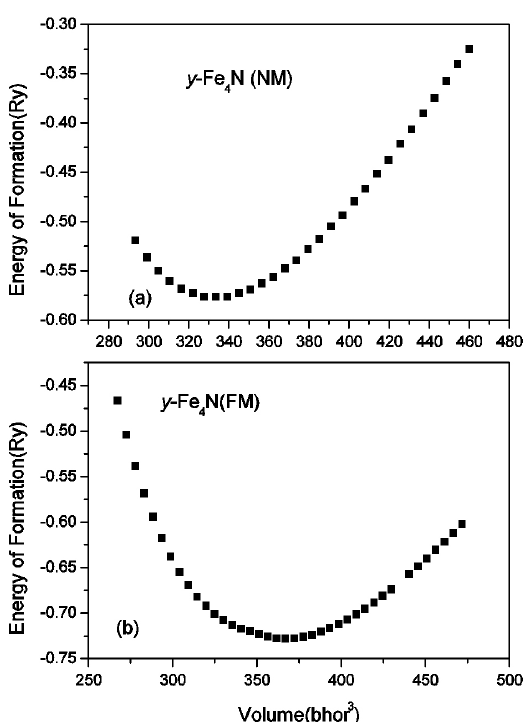
Figure 2. Energy of formation depending on the volume of nitride N in ferromagnetic and non-magnetic phases. γ – Fe 4